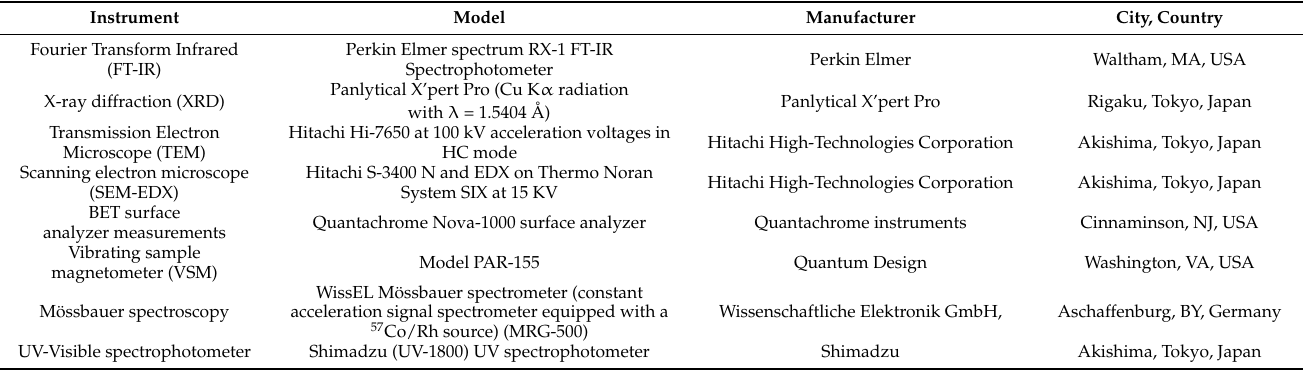
Table 1. List of various instruments and their models